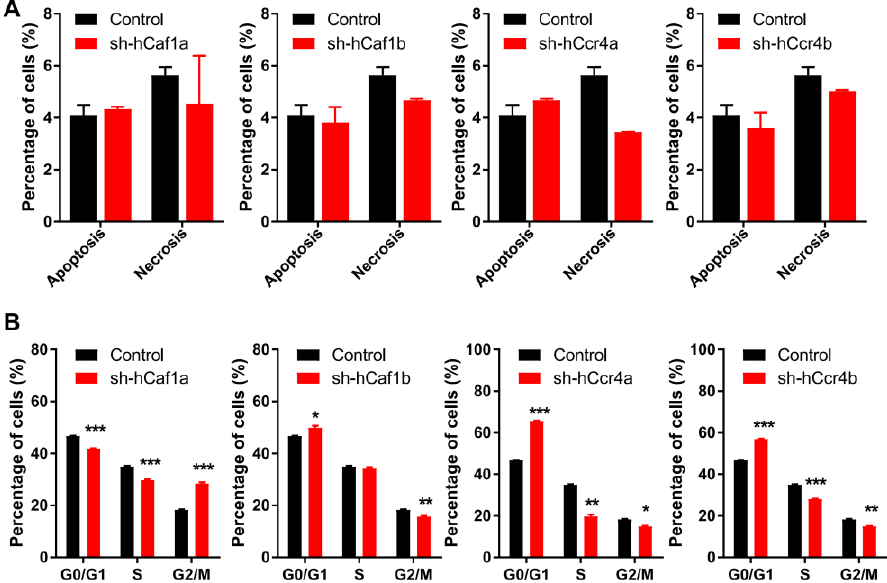
Figure 3. Depletion of hCcr4a/b or hCaf1a/b affects cell cycle progression but not cell death. ( A ) Percentages of apoptotic and necrotic cells analyzed by bivariate flow cytometry ( n = 3); ( B ) Percentages of cells at the G0/G1, S, and G2/M phases analyzed by flow cytometry ( n = 3). * p < 0.05, ** p < 0.01, and *** p < 0.001.